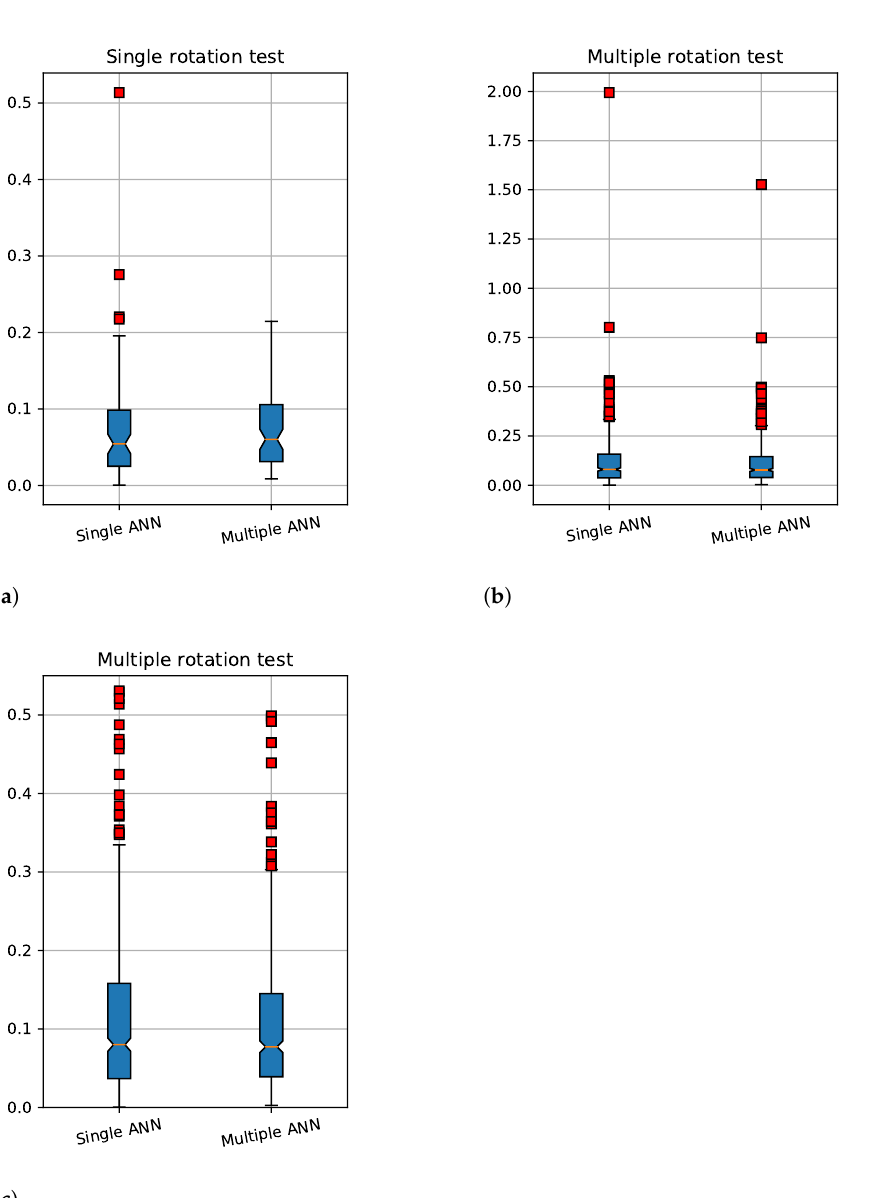
Figure 13. Experimental results—open-loop system verification, boxplot view of estimation error. ( a ) In case of a single rotation. ( b ) In case of multiple rotations. ( c ) Enlarged view from Figure 13b.